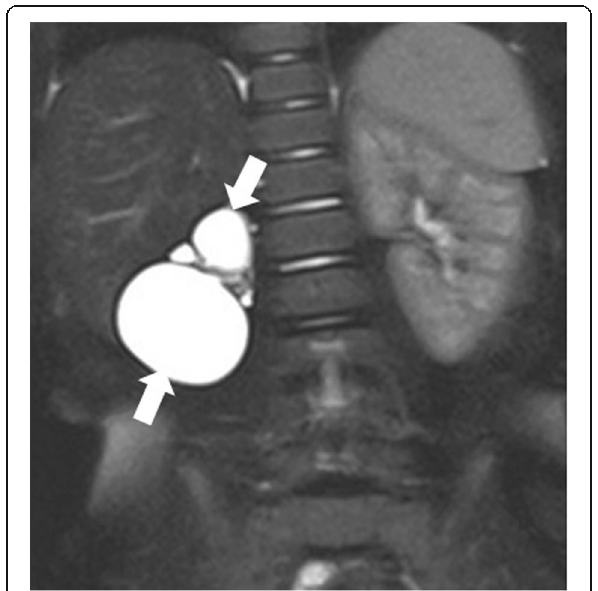
Fig. 19 A 12-day-old newborn with prenatally diagnosed right kidney cysts underwent an abdominal MRI examination. Coronal plane T2W MR image shows multiple cysts completely replacing the right kidney parenchyma (arrows). There was no discernible renal parenchyma aside from the cysts. The left kidney was normal